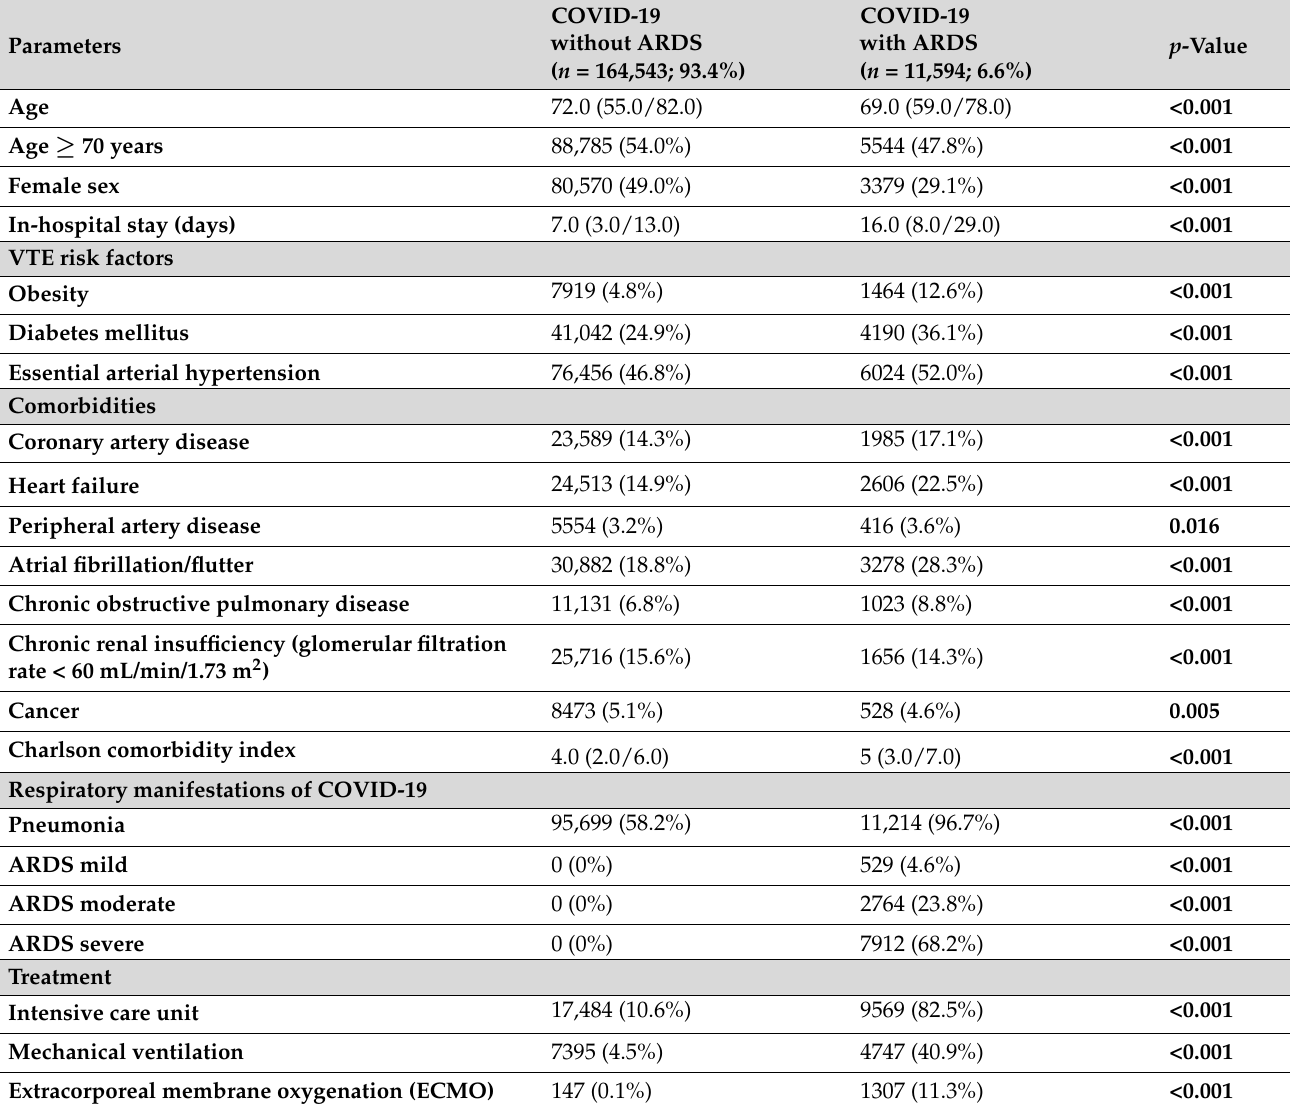
Table 1. Characteristics, medical history, presentation and adverse in-hospital events of the 176,137 hospitalized patients with confirmed COVID-19 in Germany in 2020, stratified for the presence of Acute Respiratory Distress Syndrome